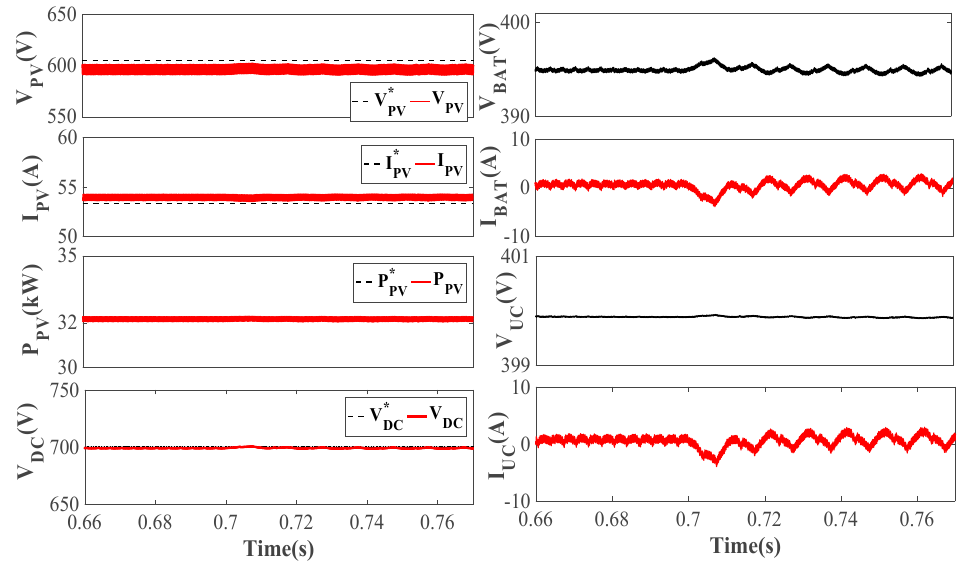
Figure 15. Unbalanced load analysis of (cid:1796) (cid:1790)(cid:1796) , (cid:1783) (cid:1790)(cid:1796) , (cid:1790) (cid:1790)(cid:1796) , (cid:1796) (cid:1778)(cid:1777) , (cid:1796) (cid:1776)(cid:1775)(cid:1794) , (cid:1783) (cid:1776)(cid:1775)(cid:1794) , (cid:1796) (cid:1795)(cid:1777) , (cid:1801)(cid:1814)(cid:1804) (cid:1783) (cid:1795)(cid:1777) . Figure 15. Unbalanced load analysis of V PV , I PV , P PV , V DC , V BAT , I BAT , V UC , and I UC .